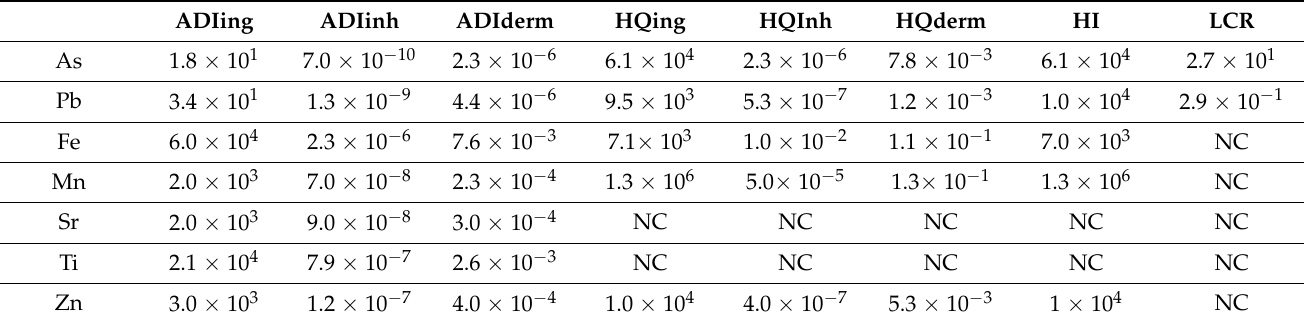
Table 6. Estimated average daily intake (ADI), hazard quotient (HQ), hazard index and cancer risk for lifetime exposure